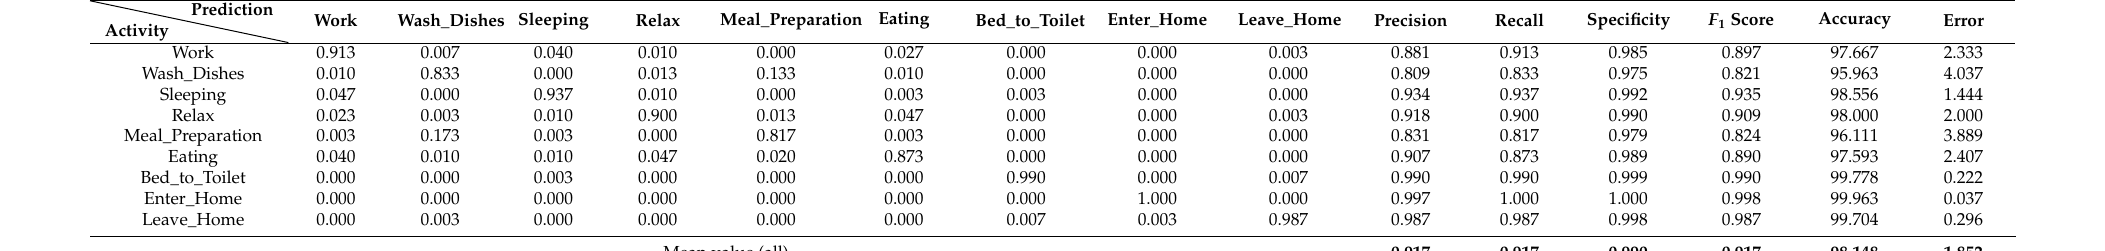
Table 3. Confusion Matrix for Activities and Evaluation of Model with Previous Activity Feature.